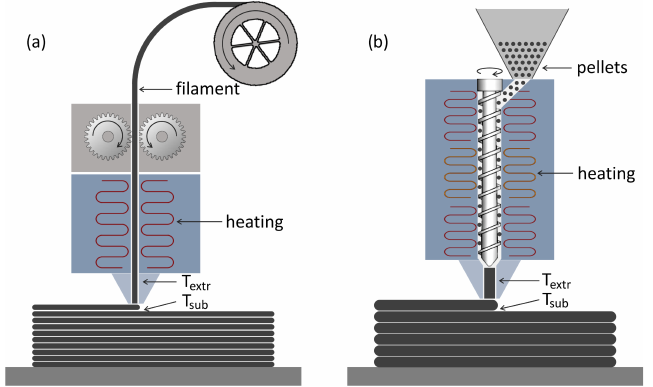
Figure 1. Concept comparison between ( a ) Fused Filament Fabrication (FFF) and ( b ) large-scale Extrusion Additive Manufacturing